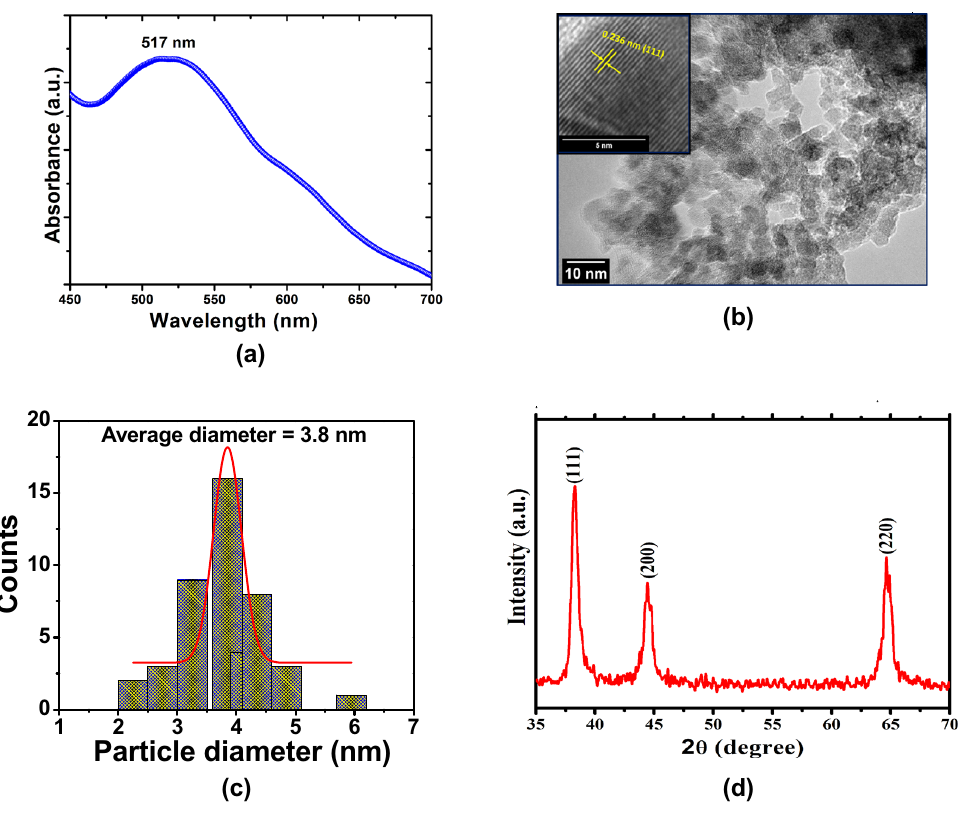
Figure 1: ( a ) UV - Vis spectrum of AuNPs synthesized at 50 s MWI. ( b ) TEM image and inset show HRTEM image of AuNPs synthesized at 50 s MWI. ( c ) Size distribution histogram obtained from TEM images of AuNPs. ( d ) XRD pattern of AuNPs synthesized at 50 s MWI.